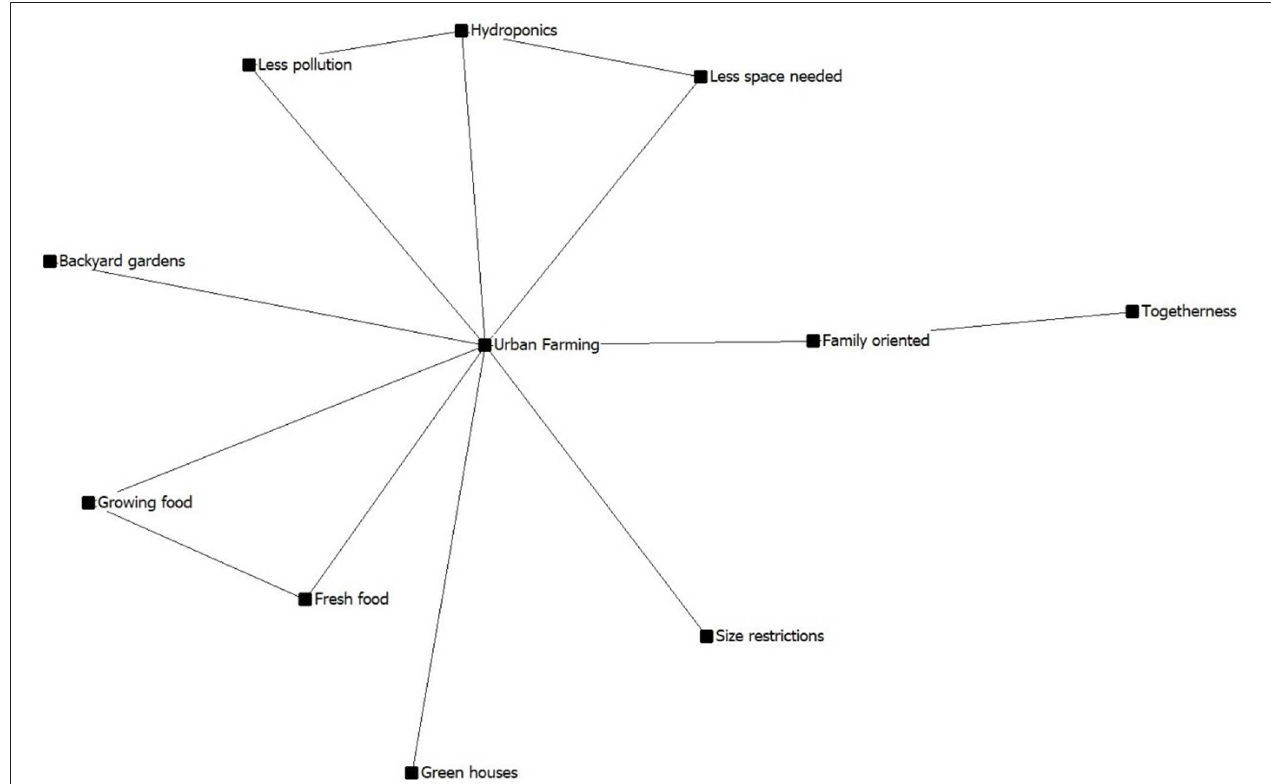
FIGURE 4 | Example of an individual network 2 (location 2, ID